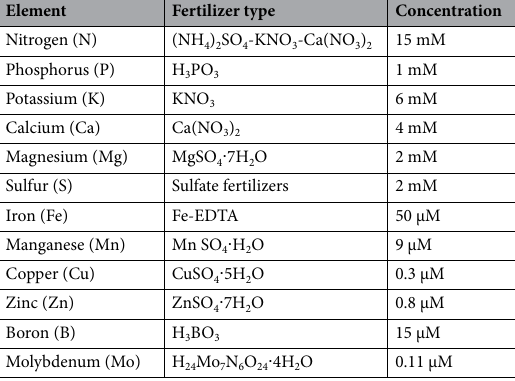
Table 1. Chemical properties of nutrient solution (Zheng et al. 23